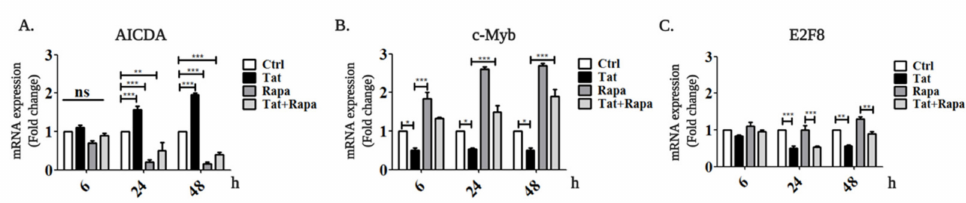
Figure 4. Tat induces activation-induced cytidine deaminase ( AICDA ) overexpression by inhibiting its repressors in an mTORC1-dependent way. Tat expression was induced in the RPMI-8866 cells by addition of 1 µ g/mL doxycycline for 6, 24 and 48 h, followed by cells being treated with 200 nM of rapamycin (Tat + Rapa) or left untreated (Tat). RPMI-8866 cells not expressing Tat were also treated with 200 nM rapamycin (Rapa) for the indicated times or left untreated (Ctrl). AICDA ( A ), c-Myb ( B ) and E2F8 ( C ) mRNA expression levels were analyzed at different time points by qRT-PCR and quantified using the 2 − ∆∆ ct method comparing the expression of the target gene in Tat-induced, rapamycin-treated and Tat-induced + rapamycin-treated cells with the untreated control (set as 1) after normalization with GAPDH gene expression. Results are obtained from three independent experiments. The statistical analyses were carried out by the one-way ANOVA test. All data are expressed as the mean ± SEM. The statistical significance was calculated between groups; *** p < 0.001, ** 0.001 < p < 0.01, * 0.01 < p < 0.5. ns comes for not segnificant, please add